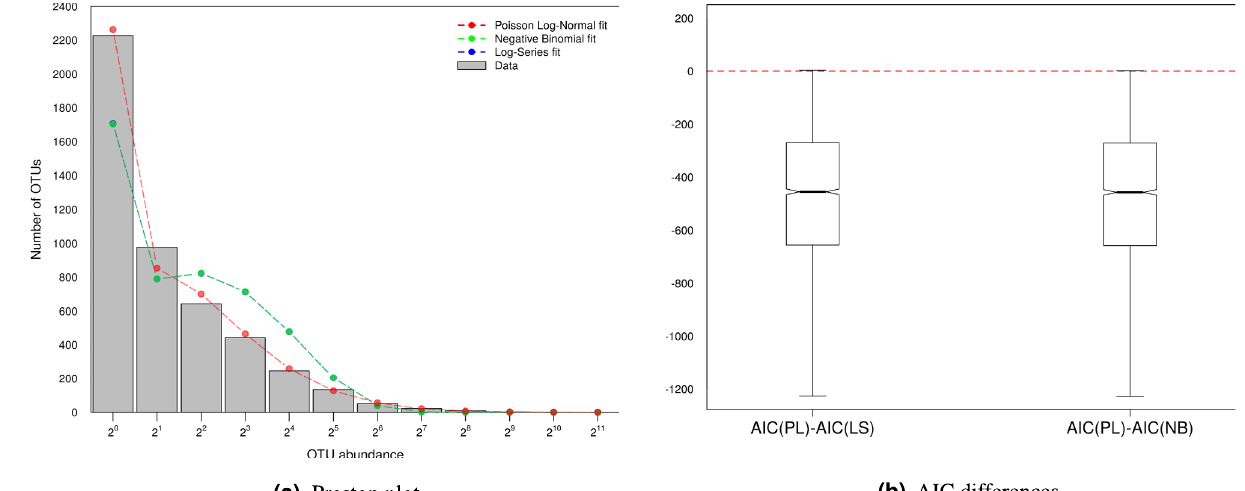
Figure 1. Fit of protein domains RSA. ( a ) Example of protein domains Preston plot fitted with three different distributions: the Poisson Log-Normal, the Negative Binomial and the Log-Series. Results refer to the bacterial genome GCA_000717515 . The Negative Binomial and the Log-Series fit overlap. This implies that the dispersion parameter α of the Negative Binomial distribution (see Eq. (6)) is close to zero. The mean and the median of the dispersion parameter obtained for the 3368 bacterial genomes are 2.67 with the observed overlap. ( b ) Distribution of the difference between the AIC obtained with the Poisson Log- Normal model (PL) and the Log-Series (LS) or the Negative Binomial (NB) model, considering all the 3368 bacterial